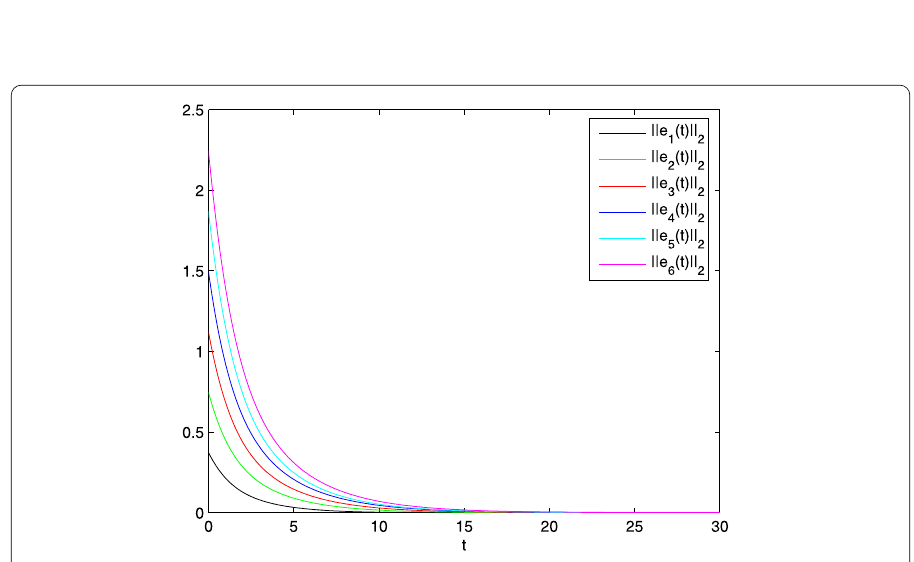
Figure 6 The synchronized error (cid:2) e i ( t ) (cid:2) 2 , i = 1,2,3,4,5,6, of system (33) under adaptive control